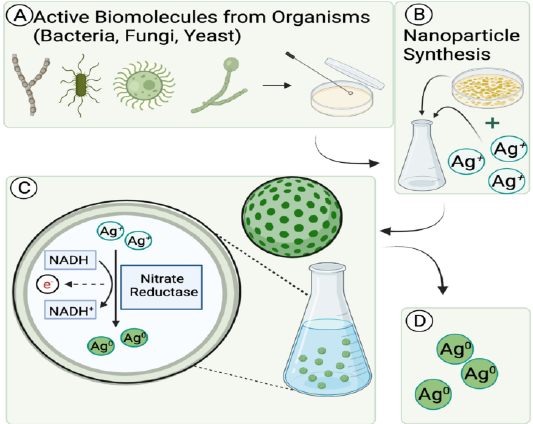
Figure 3. Representation of the role of active molecules in green metallic nanoparticle synthesis. ( A ) The culture of microorganisms from raw samples, ( B ) harvest of culture, ( C ) the reduction